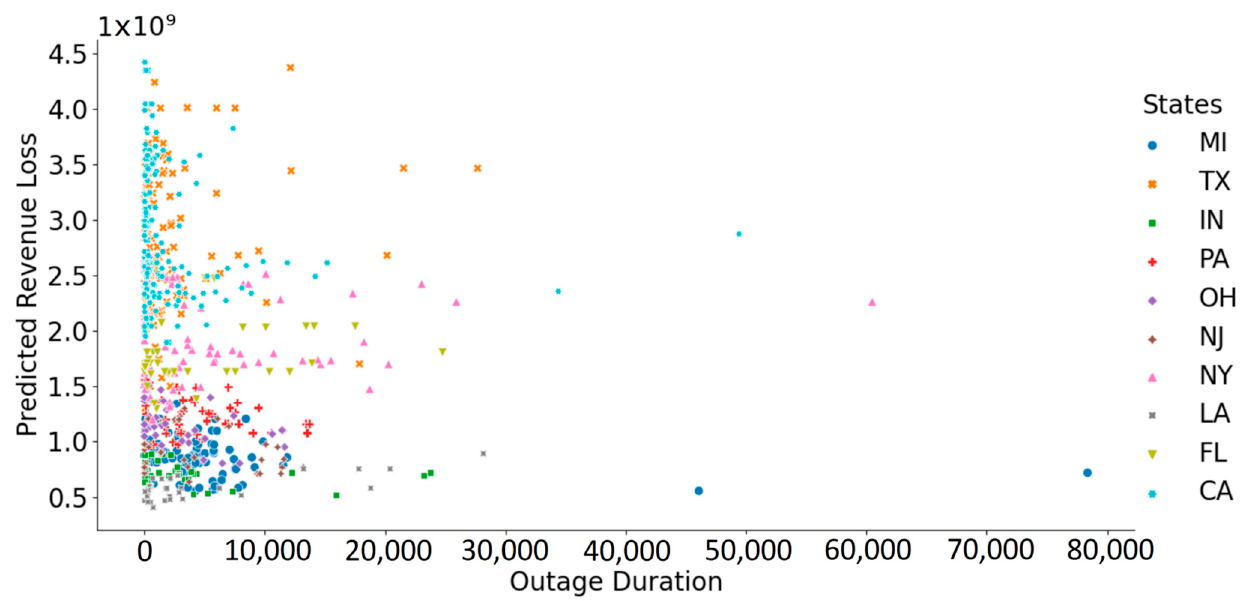
Figure 25. Scatter plot of predicted revenue loss vs. power outage duration for top 10 affected states of the U.S.